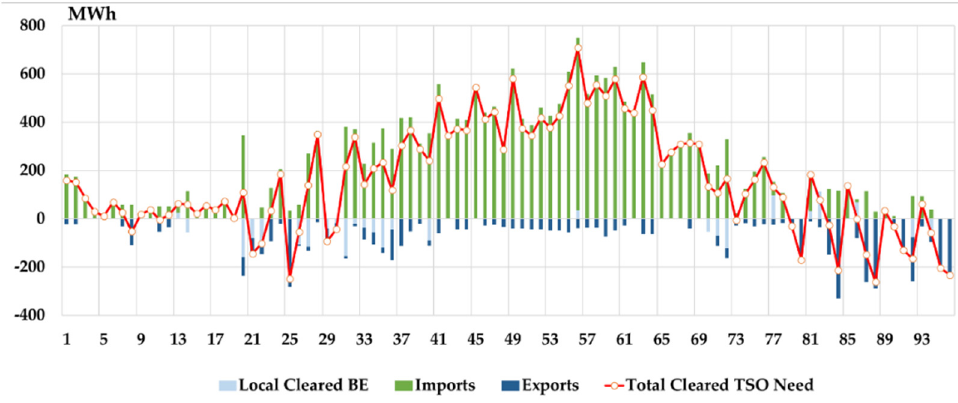
Figure 18. Power balance and cleared mFRR BE quantities per RTU for Italy.